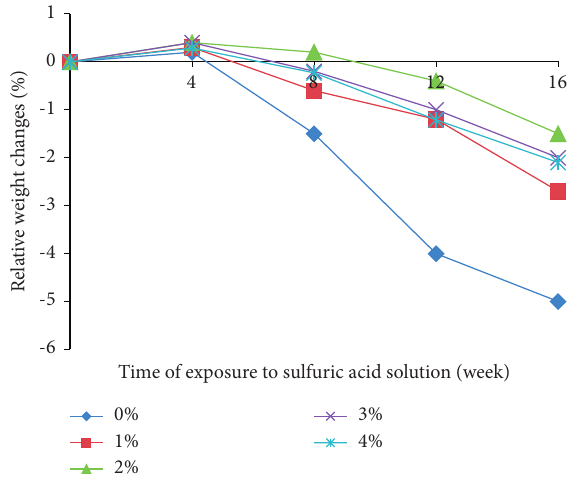
Figure 10: Relative weight changes of the concrete samples con- taining Al 2 O 3 particles in sulfuric acid.